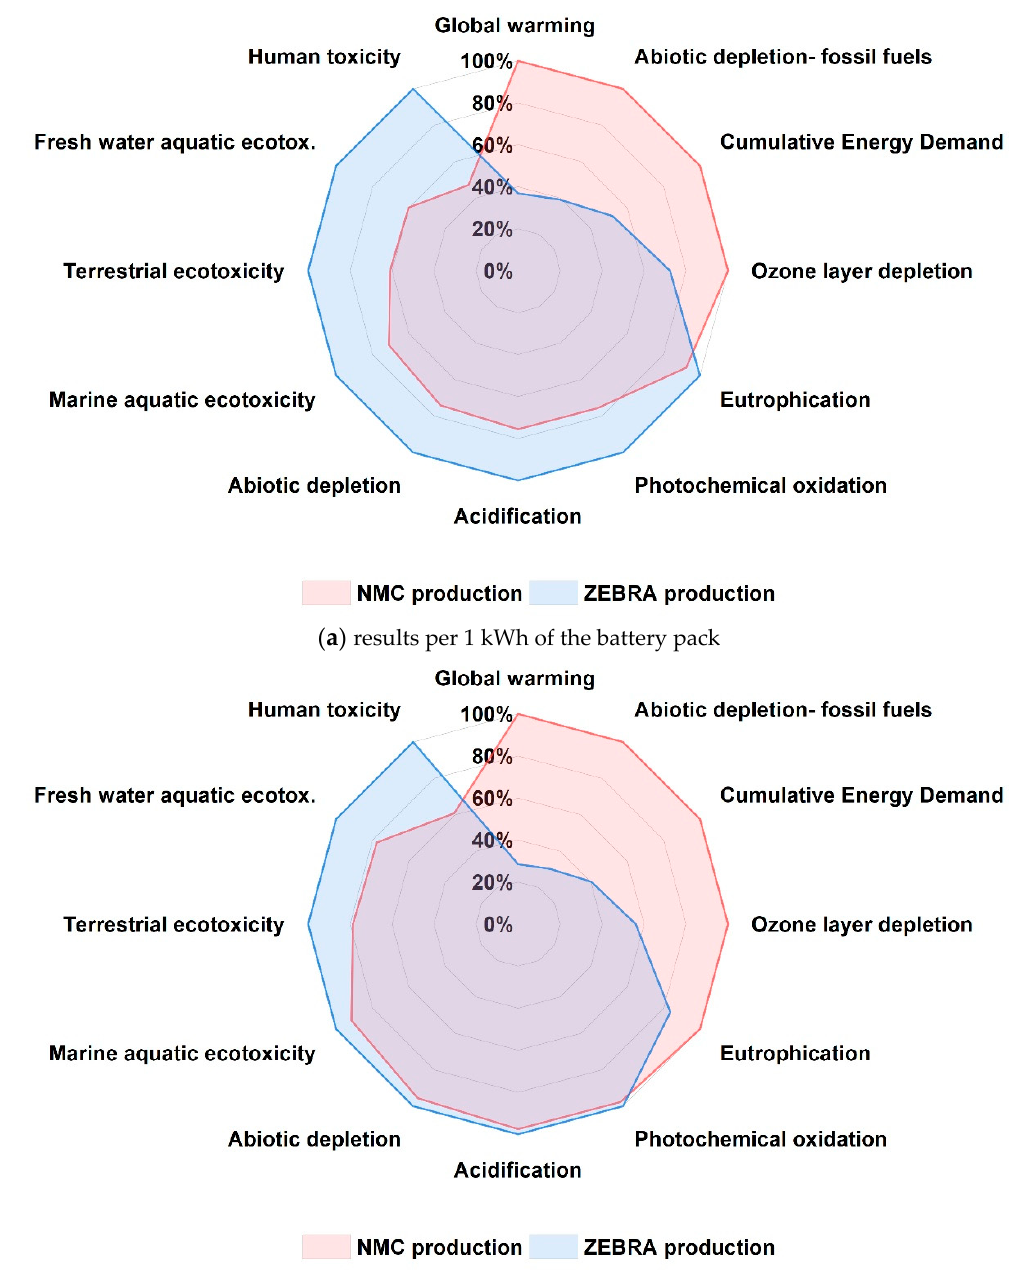
Figure 6. Comparison of the NMC111 and ZEBRA manufacturing stages ( a ) energy basis; ( b ) mass basis. The impacts are normalised to the highest score in each category.